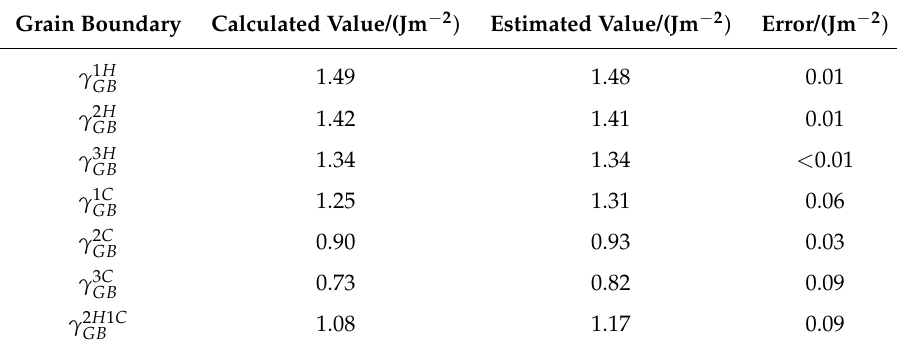
Table 1. Comparison of calculated and estimated grain boundary